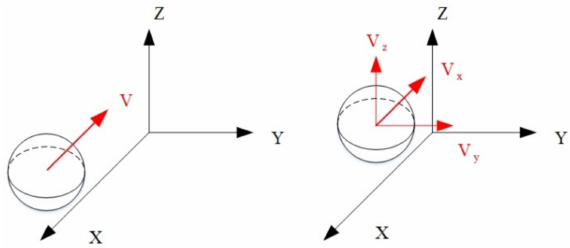
Figure 21. Velocity before and after impact.